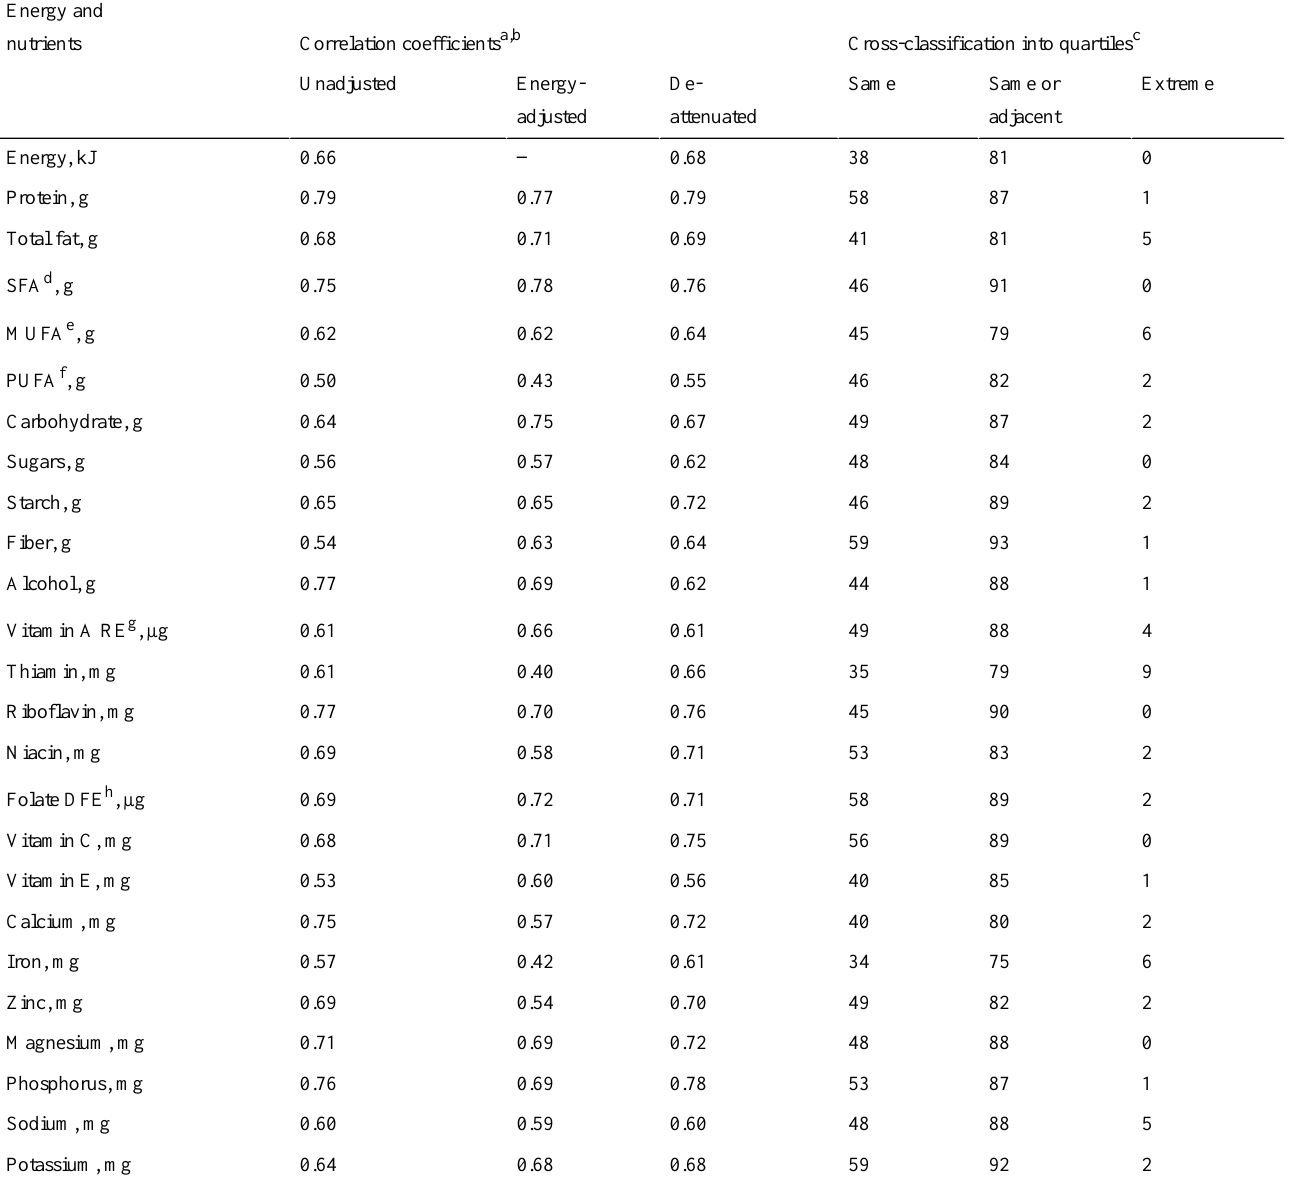
Table 2. Correlation coefficients and cross-classification of energy and nutrients between three days of 24-hour dietary recall and five days of electronic Dietary Intake Assessment.